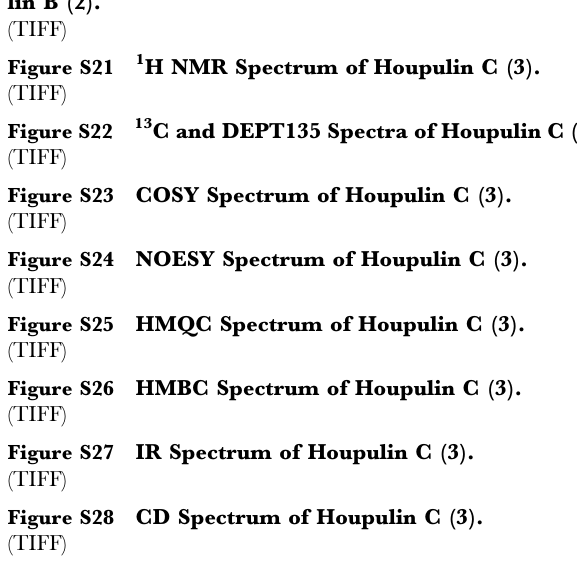
Figure S3 1 H NMR Spectrum of Houpulin A (1). (TIFF)